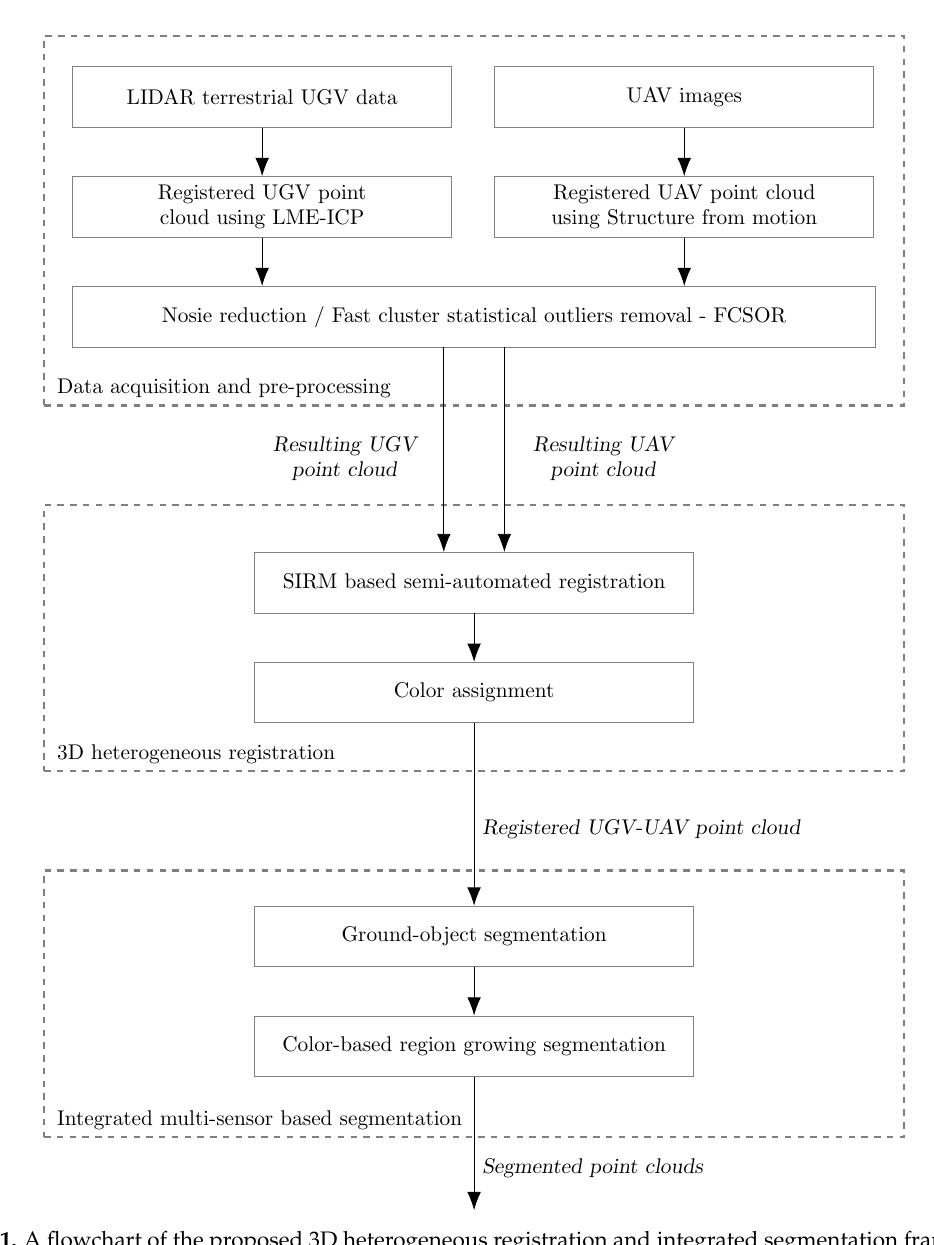
Figure 1. A flowchart of the proposed 3D heterogeneous registration and integrated segmentation